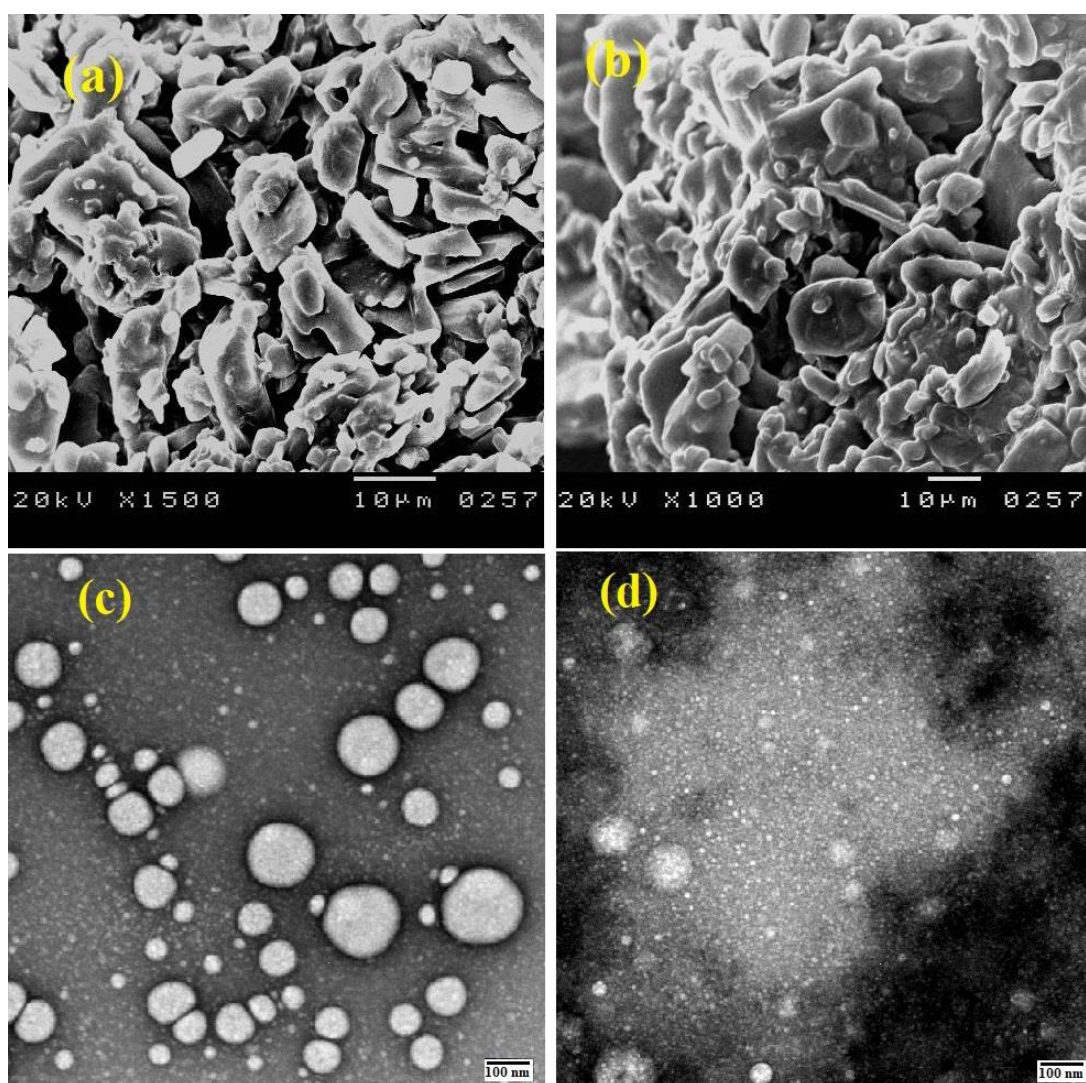
Figure 2. SEM and TEM images for LC-CS nanoparticles cross-linked with TPP ( a , c ) and TEM and SEM images ( b , d ) for LC-CS nanoparticles cross-linked with